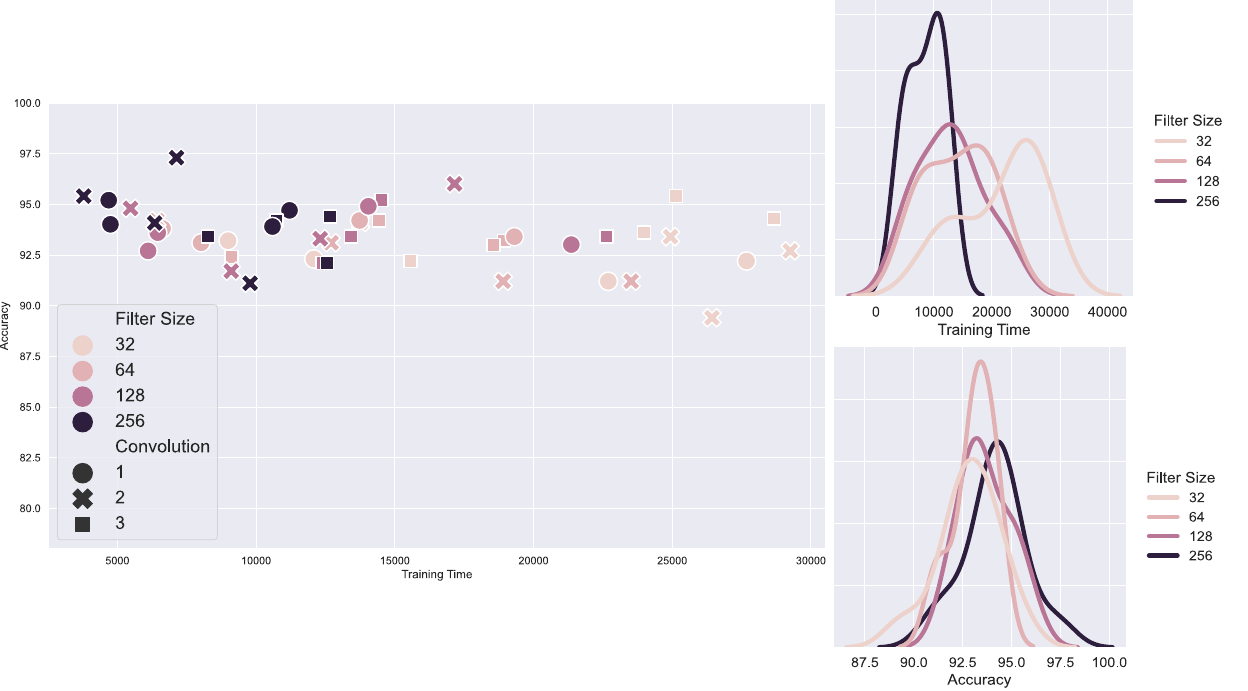
Figure 6. Filter size effect on training time and accuracy when fine-tuning BERT with different number of convolution and dense layers.